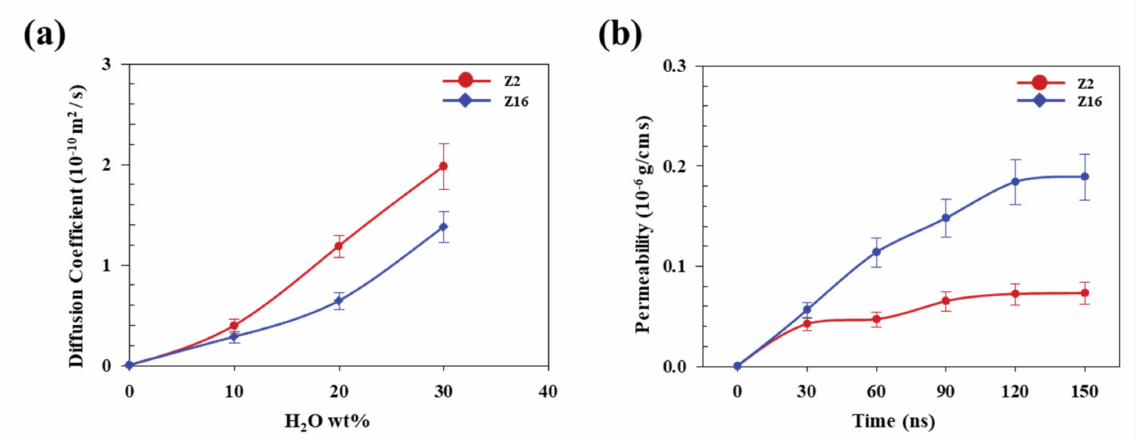
Figure 6. ( a ) H 2 O Diffusion coefficients of Z2 and Z16, and ( b ) H 2 O permeabilities of Z2 and Z16 over